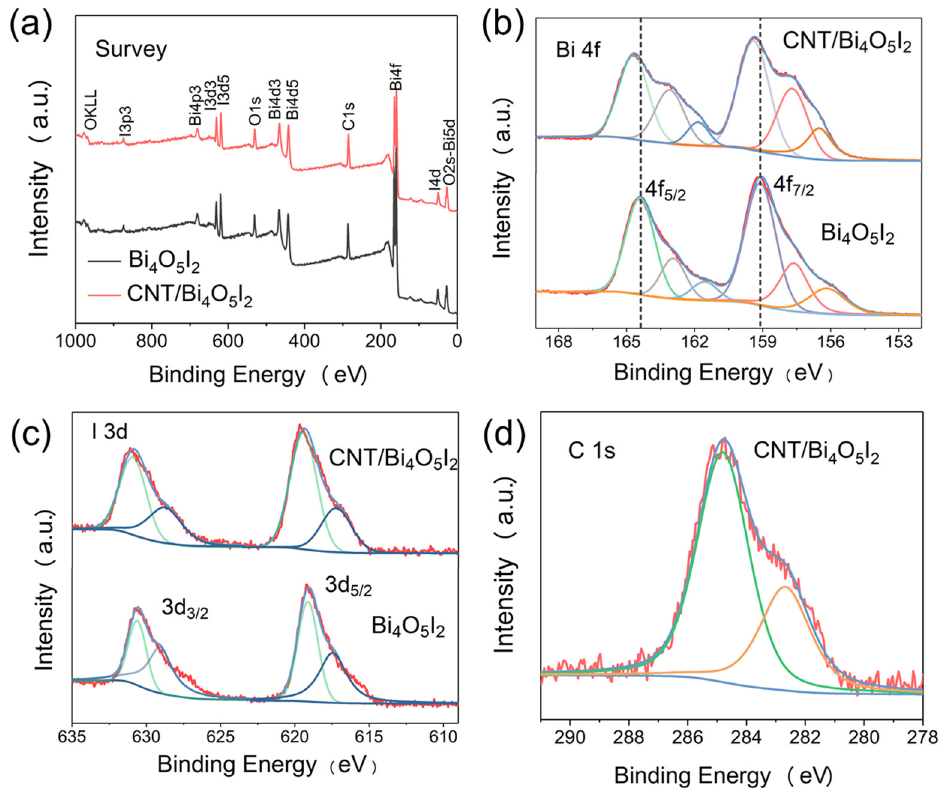
Figure 3. XPS spectra of the as-synthesized Bi 4 O 5 I 2 nanosheets and CNT/Bi 4 O 5 I 2 : ( a ) survey of the samples, ( b ) Bi 4f, ( c ) I 3d, ( d ) C 1s, respectively.